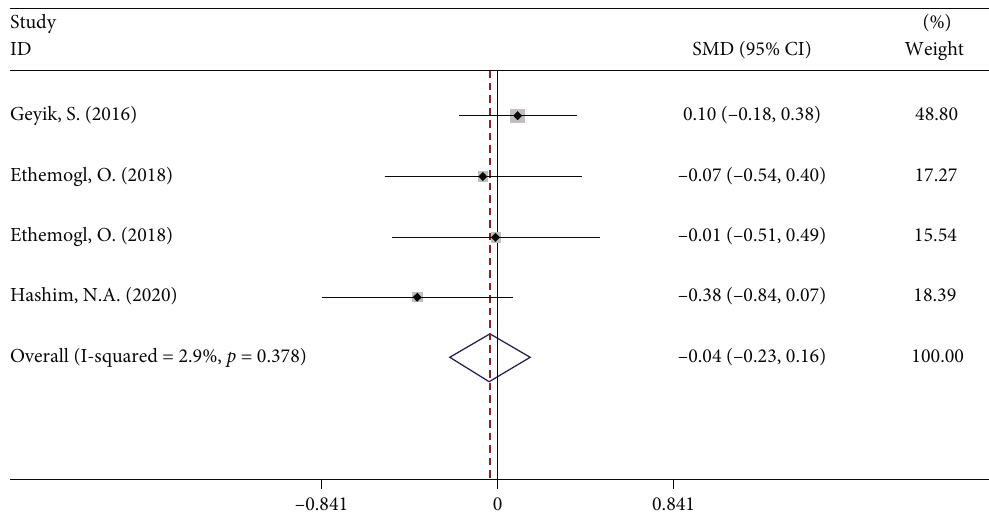
Figure 7: Meta-analysis of di ff erences in NLR levels between GBS patients after treatment and healthy controls.